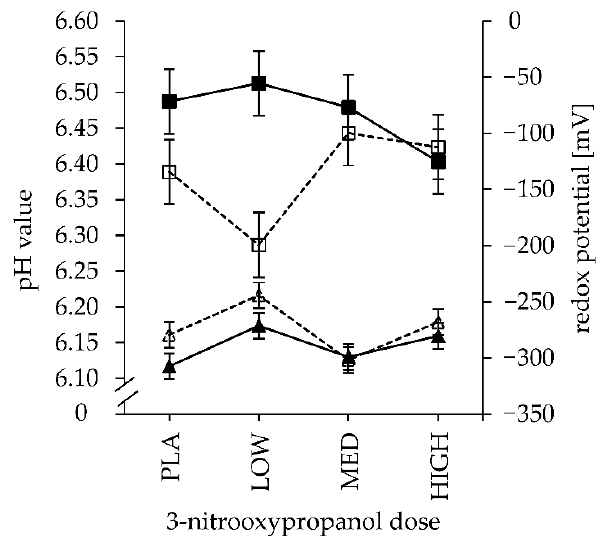
Figure 2. Effect of 3-nitrooxypropanol dose (PLA: 0, LOW: 73, MED: 160, and HIGH: 1200 mg of 3-NOP/kg of feed DM) and low- ( (cid:3) , (cid:52) , dashed line) or high- ( (cid:4) , (cid:78) , solid line) concentrate proportion in the incubated diet on pH values ( (cid:4) , (cid:3) ) and redox potential ( (cid:78) , (cid:52) ) in fermenter fluid; curve fitting according to (non)significant L and Q effects (see Table 4).